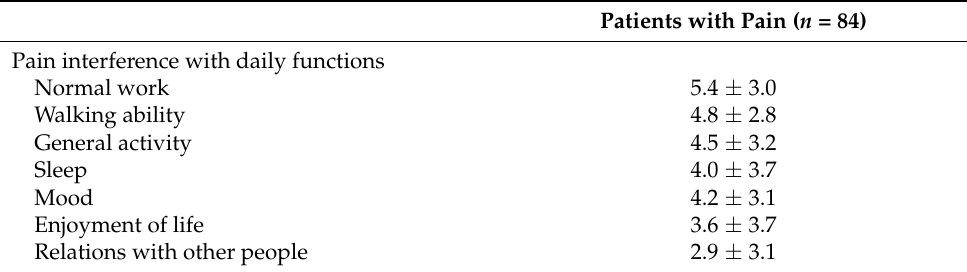
Table 2. Data referring to the patients’ ratings of pain interference with daily functions and the medication-related pain relief. Values are given as mean ± SD or number of patients (%), as